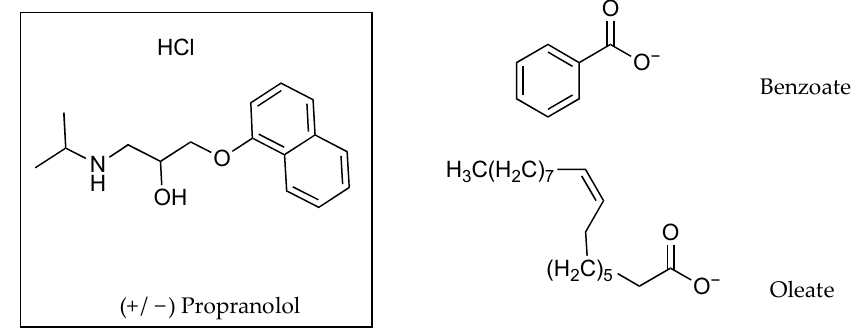
Figure 9. Propranolol plus counter ions benzoate and oleate. Table 8. PC values, solubility and flux values for propranolol (PR) racemate (RS), propranolol S-enantiomer (S-PR), individually and in conjunction with benzoate (Bz) and oleate (Ol) counter ions. According to the authors, saturated solutions were applied. Solubility values for (RS)_-PR-Ol and (S)-PR-Ol were assumed to be 0.02 mg mL − 1 , the concentration determined to be their critical micellular concentration (CMC). For solubility and permeation experiments n = 3, flux values represent the mean ± S.D. Adapted with permission from [33], Elsevier, 2010.